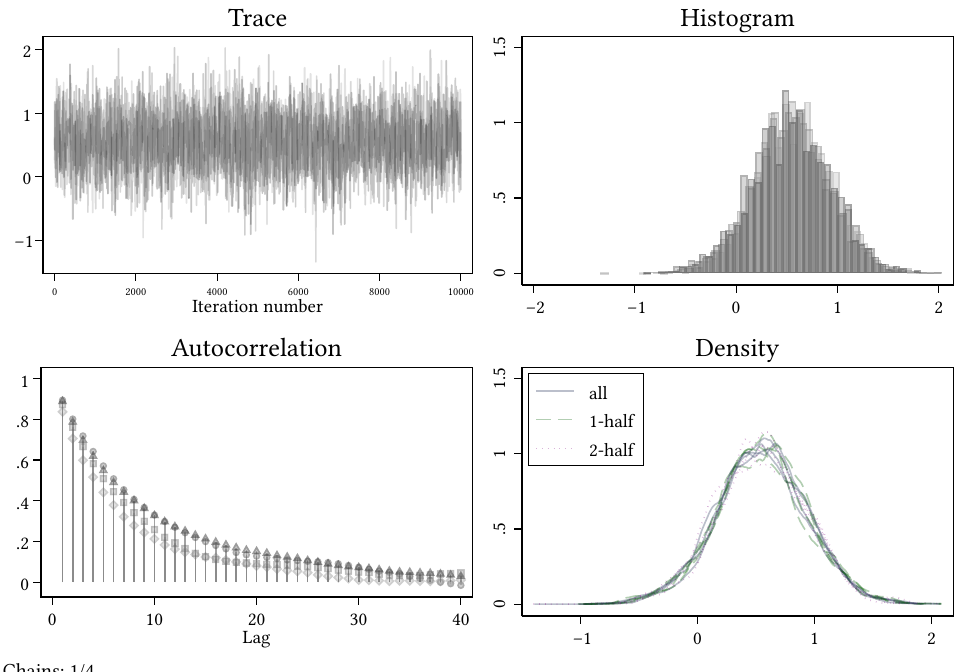
Figure A2. How awareness of the price effect influences the response to the market price. The Low Info